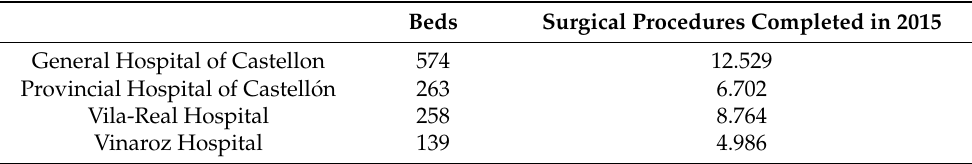
Table 1. Characteristics of the hospitals included in the study.